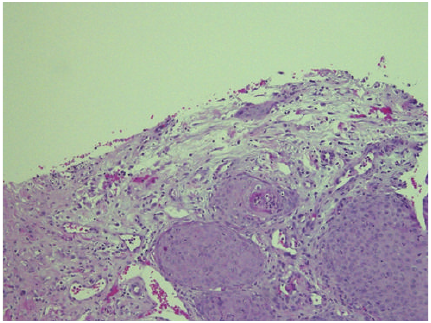
Figure 2: Biopsy of soft tissue mass which revealed high grade urothelial carcinoma with squamous features.